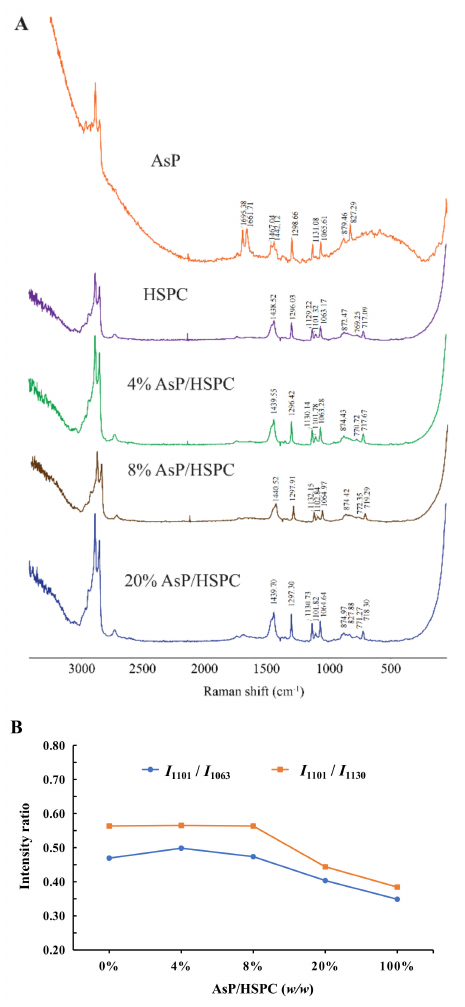
Figure 5. ( A ) Raman spectra of AsP–PC hydrates with various AsP/HSPC ratios ( w/w ); ( B ) the intensity ratios of I 1101 / I 1063 and I 1101 / I 1130 in Raman spectra. Three characteristic Raman bands for the fatty acid v (C–C) stretch at 1060–1140 cm − 1 were analyzed to determine the effects of AsP on the conformational order of the